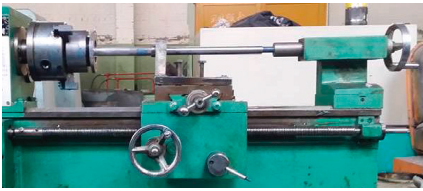
Figure 13: Experimental